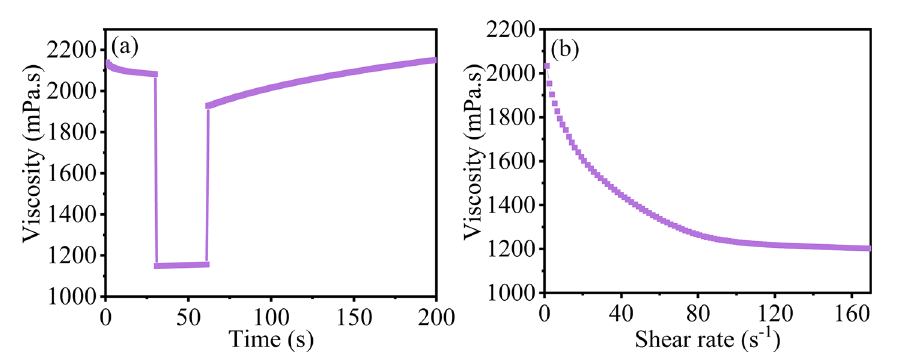
Figure 5. ( a ) The fluorescence spectra of the ZnO QDs inks with different PVP contents. ( b ) The fluorescence peak histogram of the ZnO QDs inks with different PVP contents. ( c ) The viscosity histogram of the ZnO QDs inks with different PVP contents.